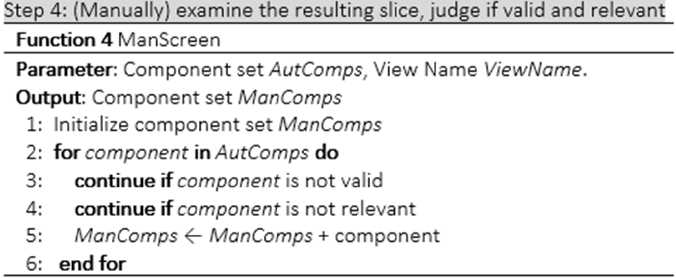
Figure 4. Pseudo-codes for the manual screening algorithm (Step 4).